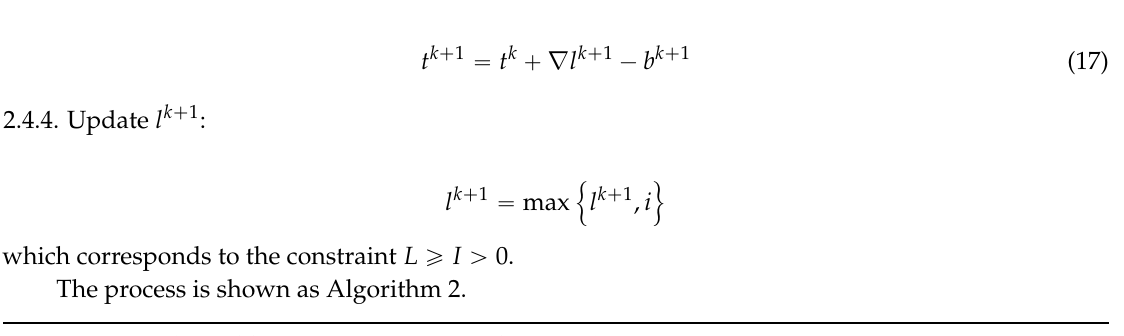
Algorithm 2: (Variable Exponent Functional